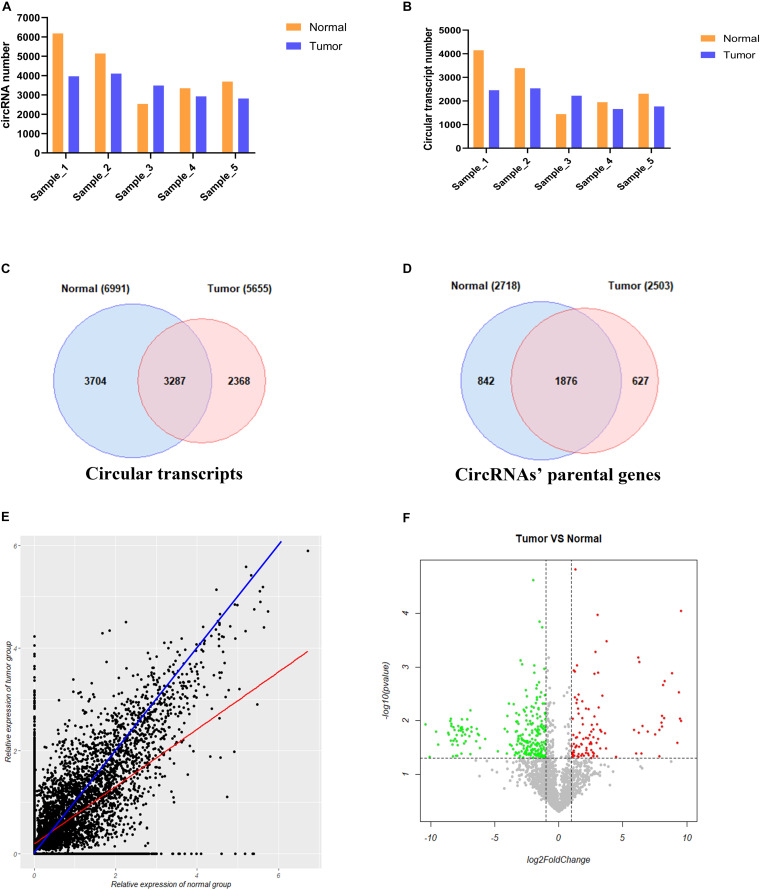
Analysis of circRNA full-length transcripts expression in tumor and adjacent normal tissues in cervical cancer. (A) Quantitative analysis of circRNA in tumor and adjacent normal tissues among different patients; (B) Quantitative analysis of circRNA full-length transcripts in tumor and adjacent normal tissues among different patients; (C) Statistical analysis of the number of circRNA full-length transcripts in tumor and adjacent normal tissues; (D) Statistical analysis of the number of parental genes producing circular RNA full-length transcripts in tumor and adjacent normal tissues; (E) Analysis of the expression of circular full-length transcript in tumor and adjacent normal tissues. The blue line represents the same transcript expression between the two groups, and the red line represents a straight line fitted according to the relative expression distribution of all circular transcripts in two groups; (F) Volcano plot showing differentially expressed circRNA full-length transcripts in cervical cancer. Red points and green points represent significantly up-regulated and down-regulated circRNA full-length transcript isoforms, respectively.